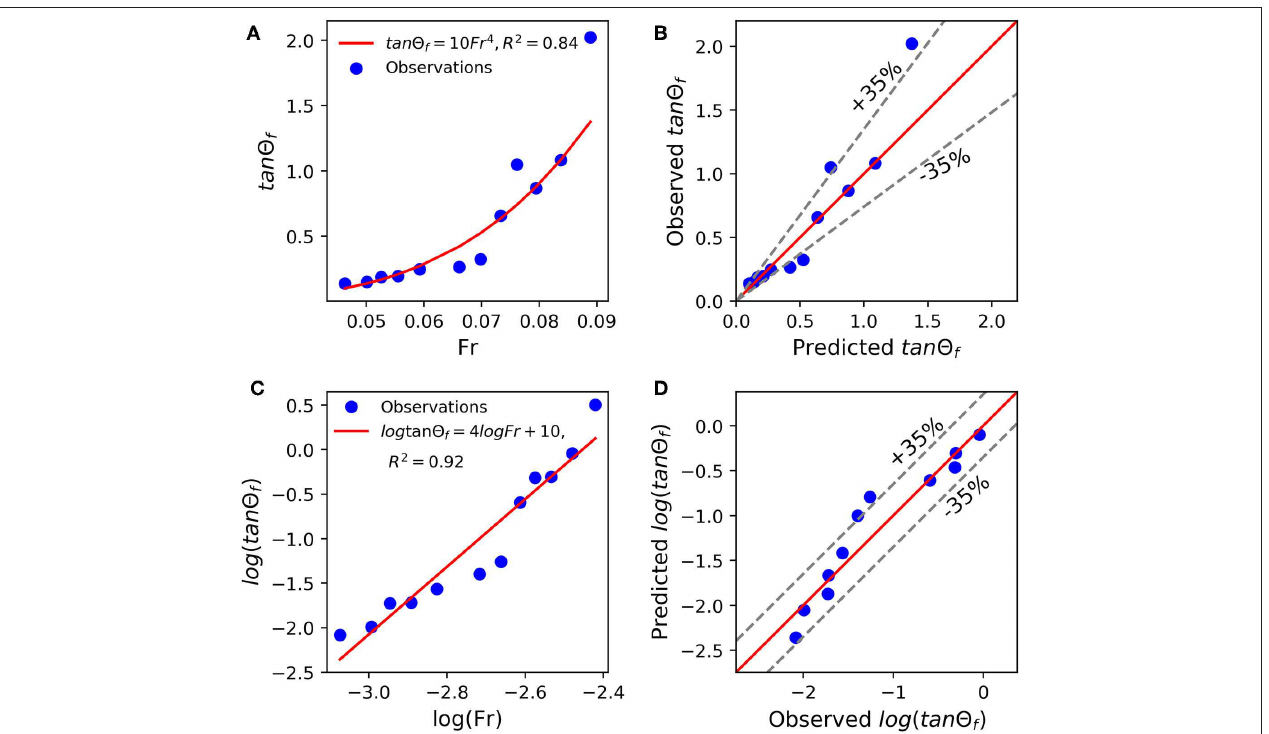
FIGURE 6 | Experiment B (A) Power-law fit (B) Predicted vs. Observed values based on power law fit (C) log-log fit (D) Predicted vs. observed values based on log-log